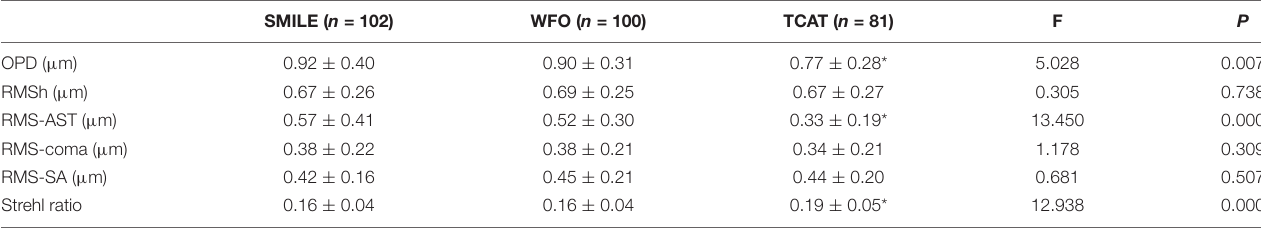
TABLE 3 | Comparison of corneal aberrations and optical quality among the three groups at 1 month postoperatively. SMILE ( n =